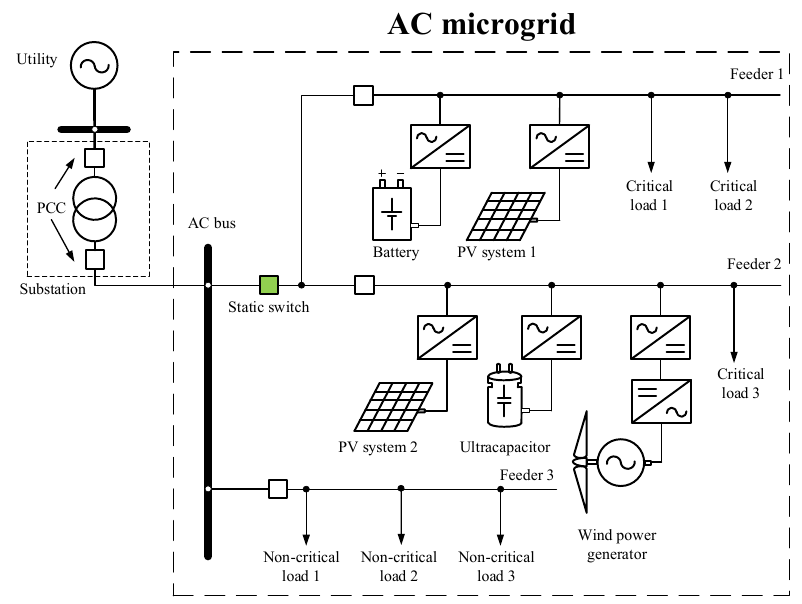
Figure 2. AC microgrid structure.